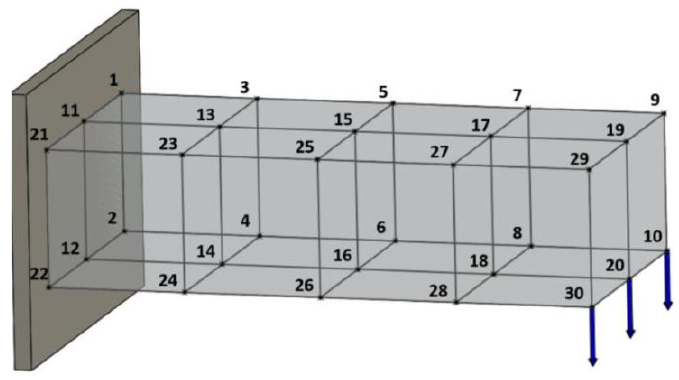
Figure 2. Global node IDs in a prismatic structure composed of 8 elements and 30 nodes.